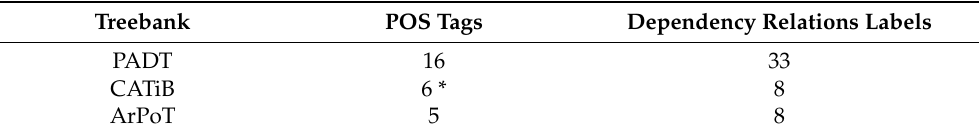
Table 4. POS tags and Dependency Relations Labels in each dataset.